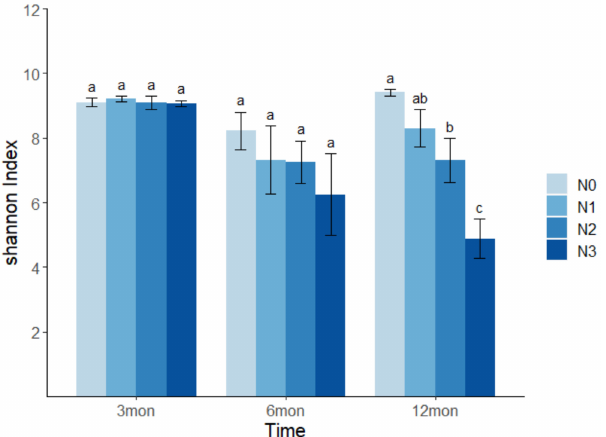
Figure 1. Effects of N deposition on soil bacterial Shannon diversity index. Different letters indicate significant differences among treatments within the same sampling time ( p < 0.05,